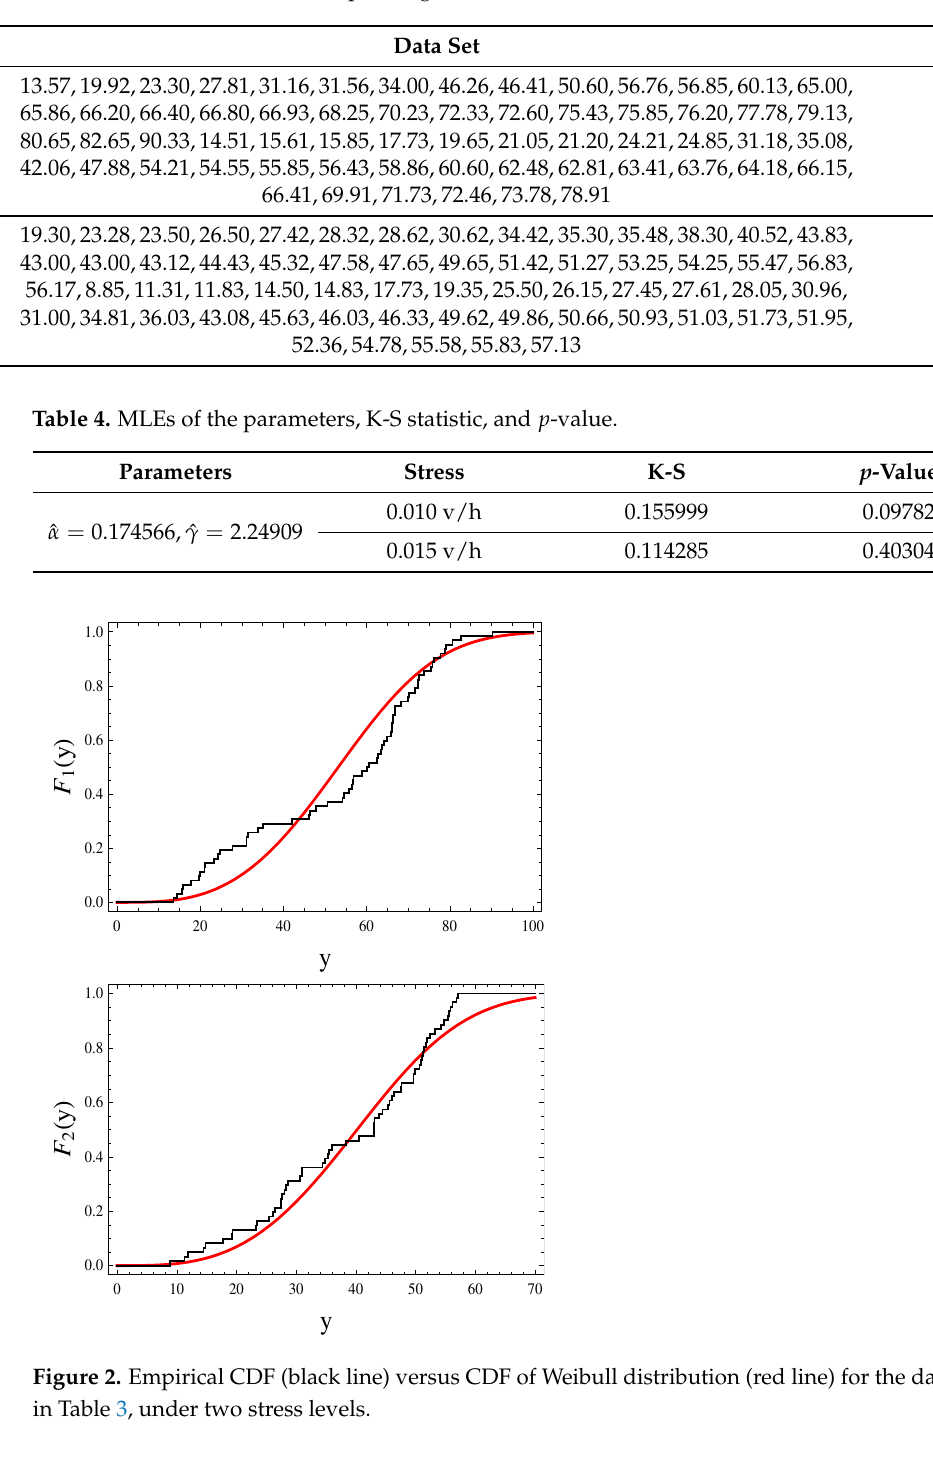
Table 3. Lifetime data from ramp-voltage tests.